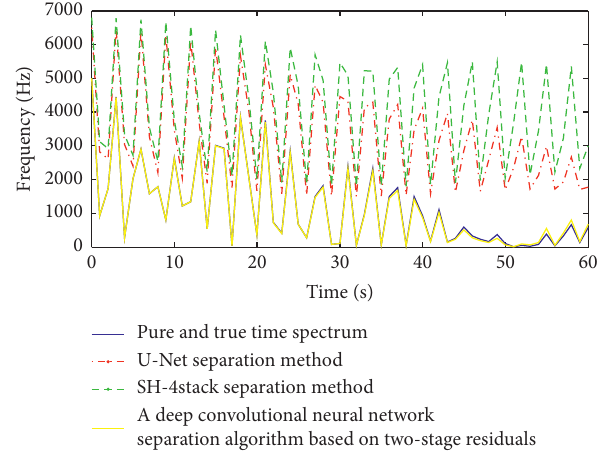
Figure 4: Visualization of the time